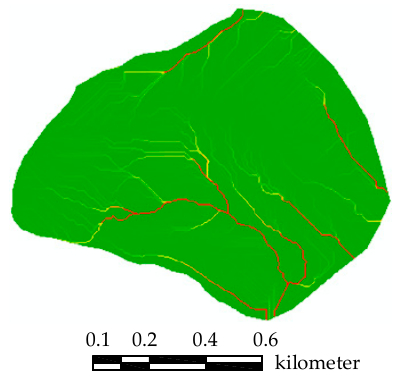
Figure 10. The water flow simulation diagram.